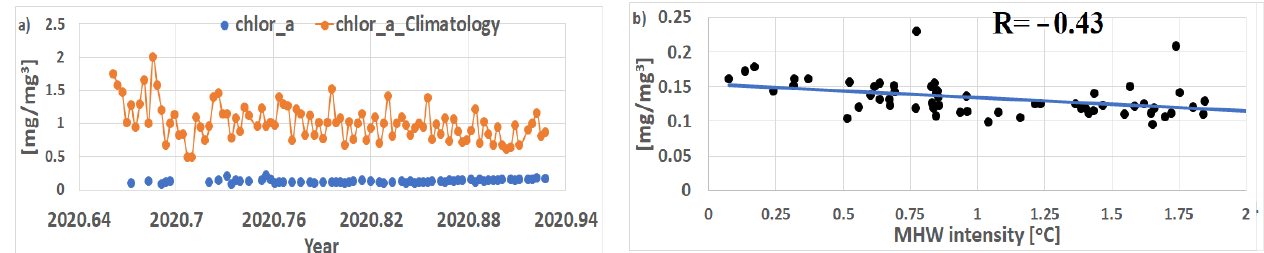
Figure 19. Representative of the chlorophyll_concentration_in_sea_water (chlor_a) values and its climatological values during the study case 4, which extends from 30 August 2020 to 5 December 2020 ( a ); scatter plots of marine heat wave intensity and chlor_a concentration during the study case 2 ( b ).